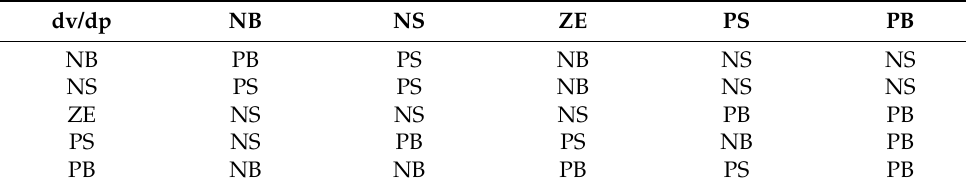
Figure 20. Error, change in error, and duty cycle membership functions of fuzzy inference system: ( a ) membership functions of input variable Ipv; ( b ) membership functions of input variable Vpv; ( c ) membership functions of output variable PWM (or) duty. Table 3. Fuzzy control rule